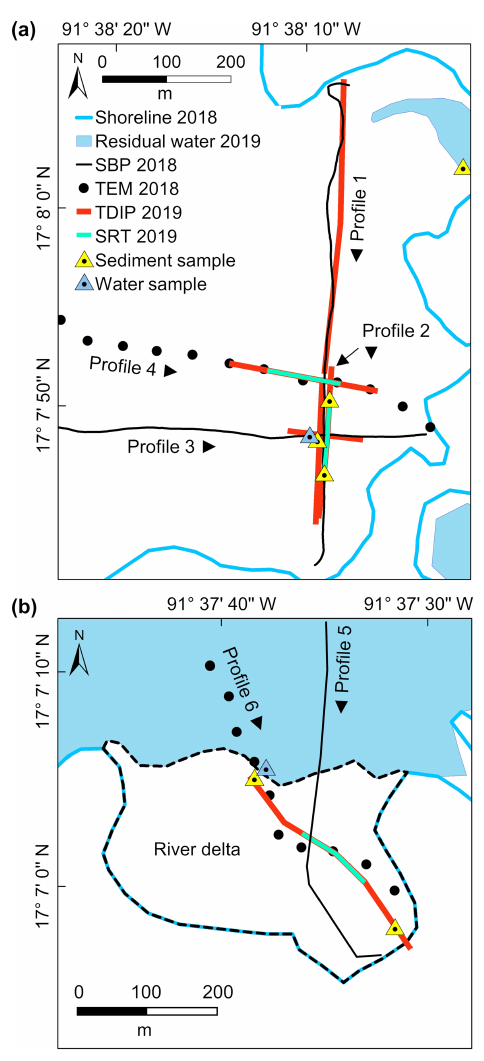
Figure 2. Layout of the geophysical survey on lakes Metzabok (a) and Tzibaná (b) in October 2019 (after the sudden lake-level drop) including sub-bottom profiler (SBP), transient electromag- netic (TEM), time-domain induced polarization (TDIP), and seis- mic refraction tomography (SRT) measurements. The geophysical measurements discussed here are grouped into six profiles; black triangles next to the profile names indicate the profile orientations. Yellow and blue triangles indicate sampling locations for sediment and water samples analyzed in the laboratory, respectively. The dashed black line in (b) indicates the dry part of the river delta ex- posed during October